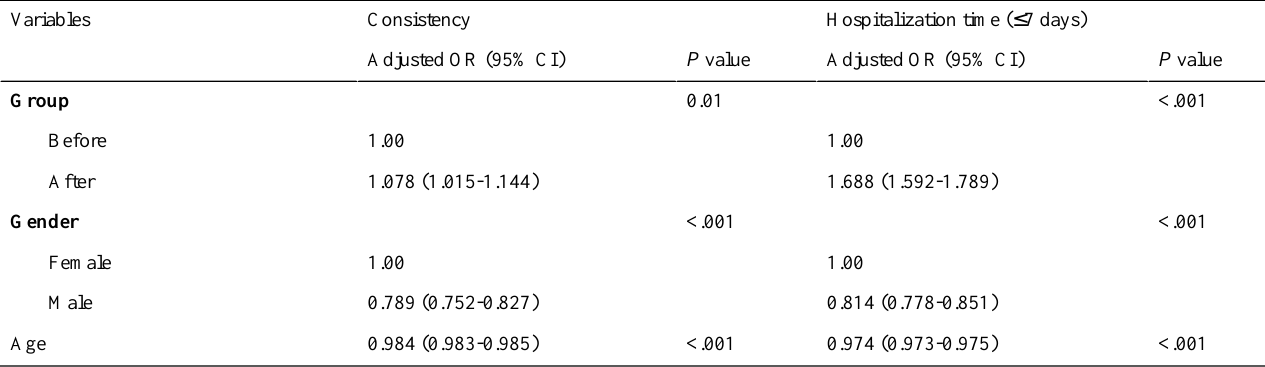
Table 4. Multivariable logistic regression analysis of the effects of clinical decision support systems.